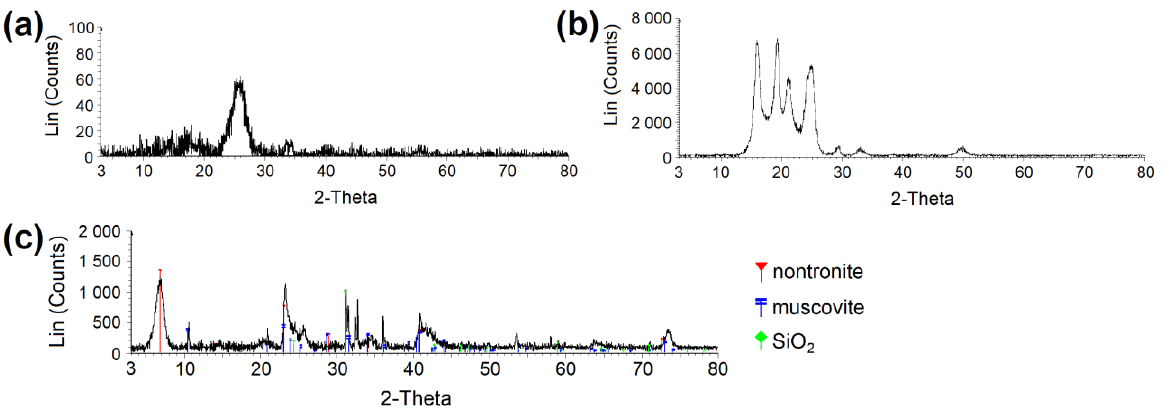
Figure 2. XRPD diffractogram proving the crystalline phase in ( a ) CEL and ( b ) PP. ( c ) Determination of clay phases in clay material. CEL — cellulose, PP —